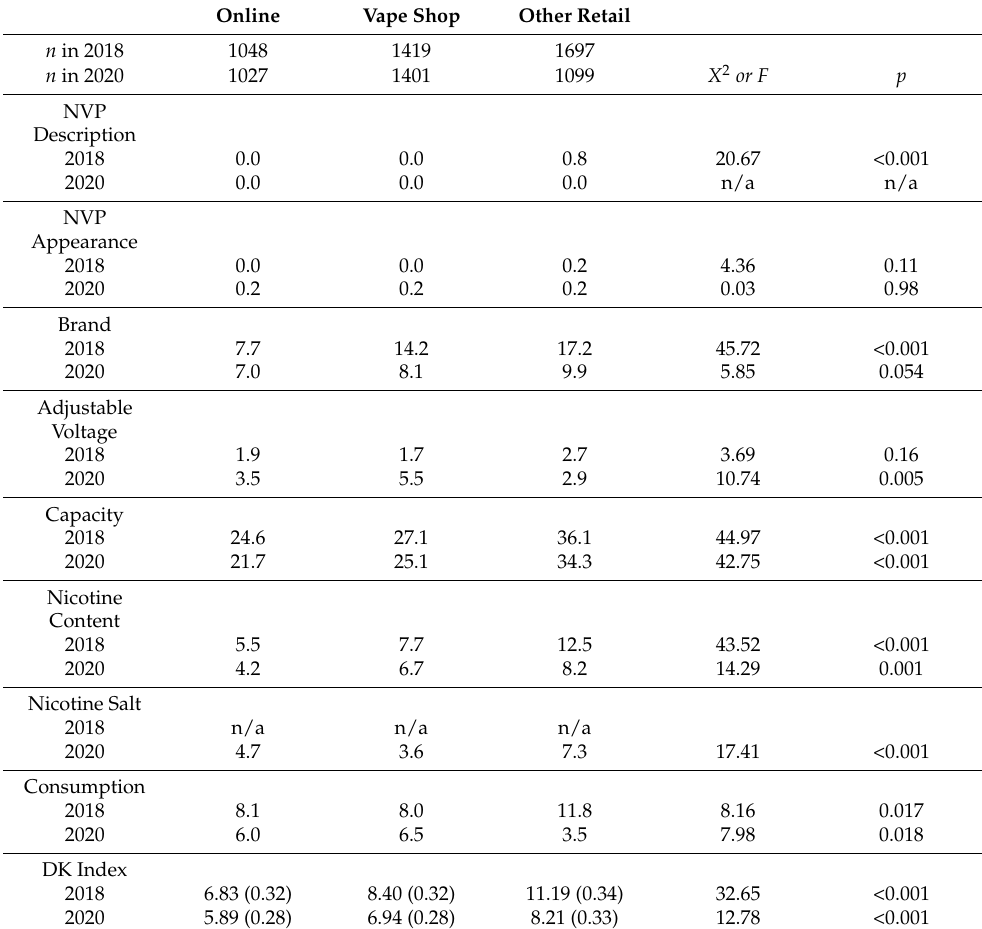
Table 4. DK percentages by purchase